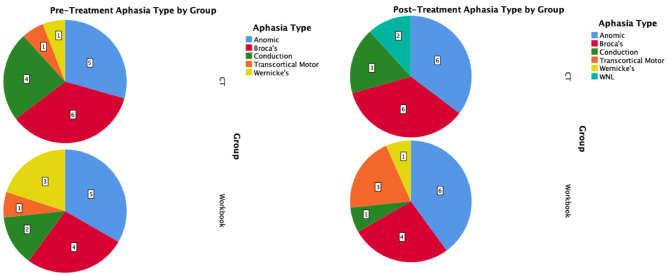
Pre-treatment and post-treatment aphasia subtypes as calculated by the WAB-R shown as pie-charts by intervention group.